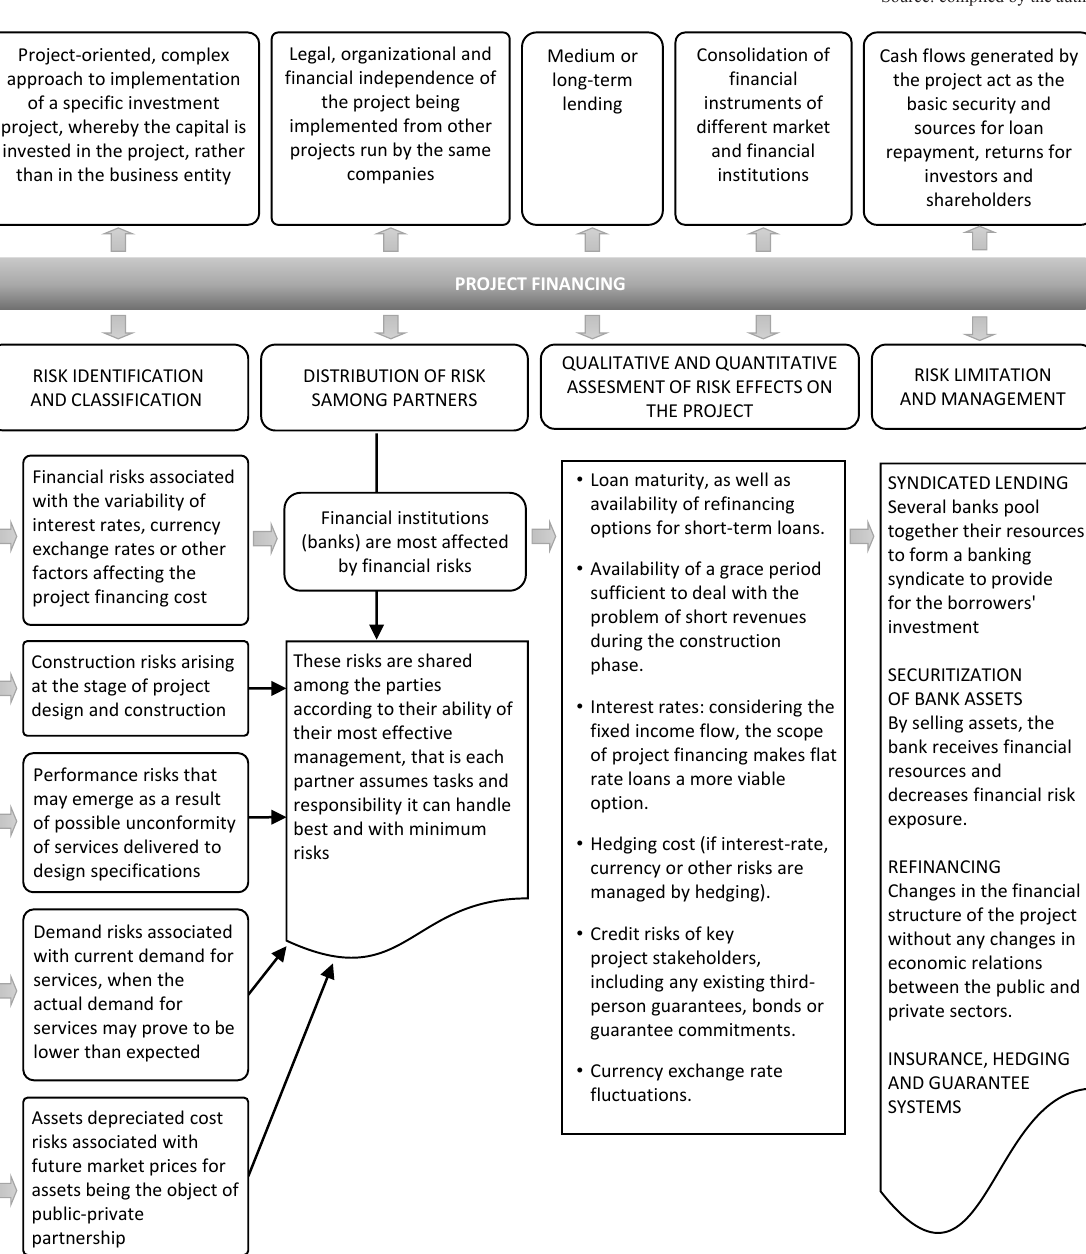
Figure 2. Project finance risk management for public-private partnership